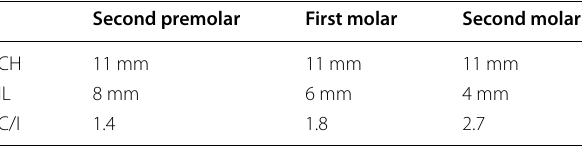
CH crown height, IL implant length, C/I crown-to-implant ratio